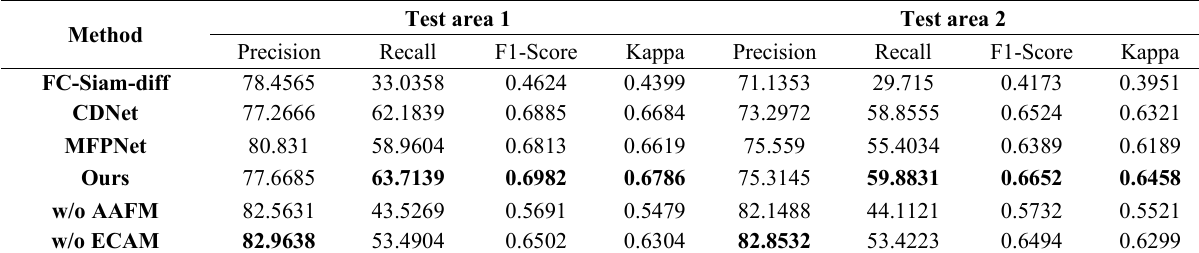
Table 1 . Quantitative results of experimental comparison methods in the two test areas.